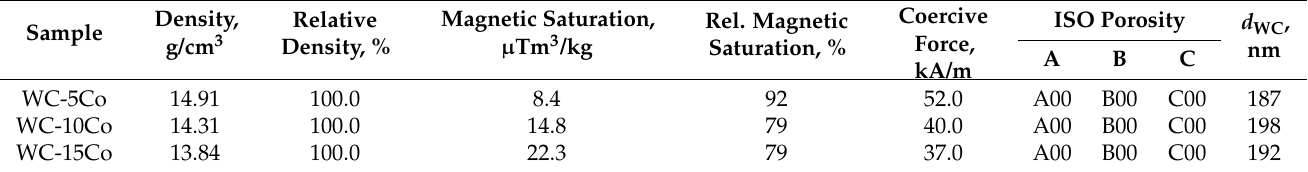
Table 2. Characteristics of consolidated